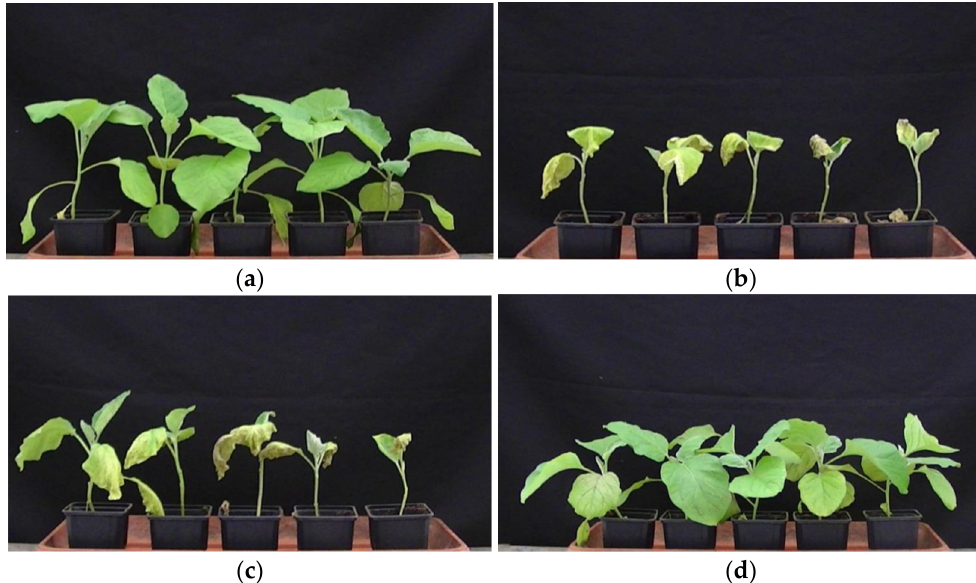
Figure 6. Verticillium wilt symptoms caused on Z13 ( a ) and Z7 ( b ) treated plants, controls ( V. dahliae inoculated) ( c ) and mock inoculated plants ( d ). The photograph was taken at 20 dpi.